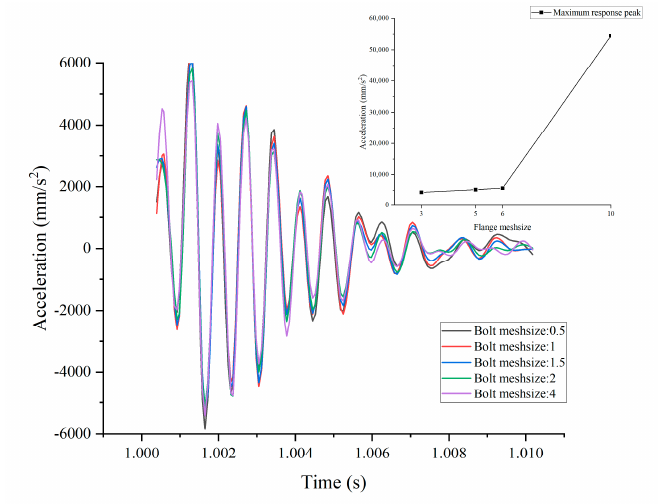
Figure 8. Force-displacement curve (varies with mesh size).